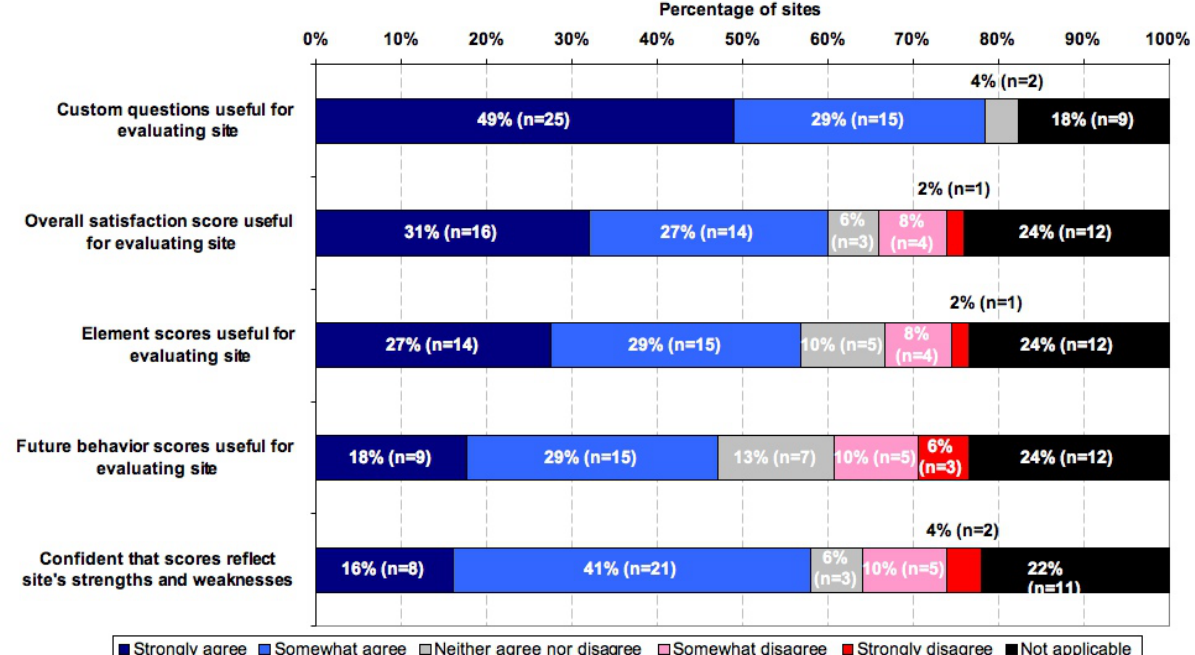
Figure 1. Usefulness of custom questions and ACSI survey scores as reported by participating NIH website teams (Method: Final Website staff survey,